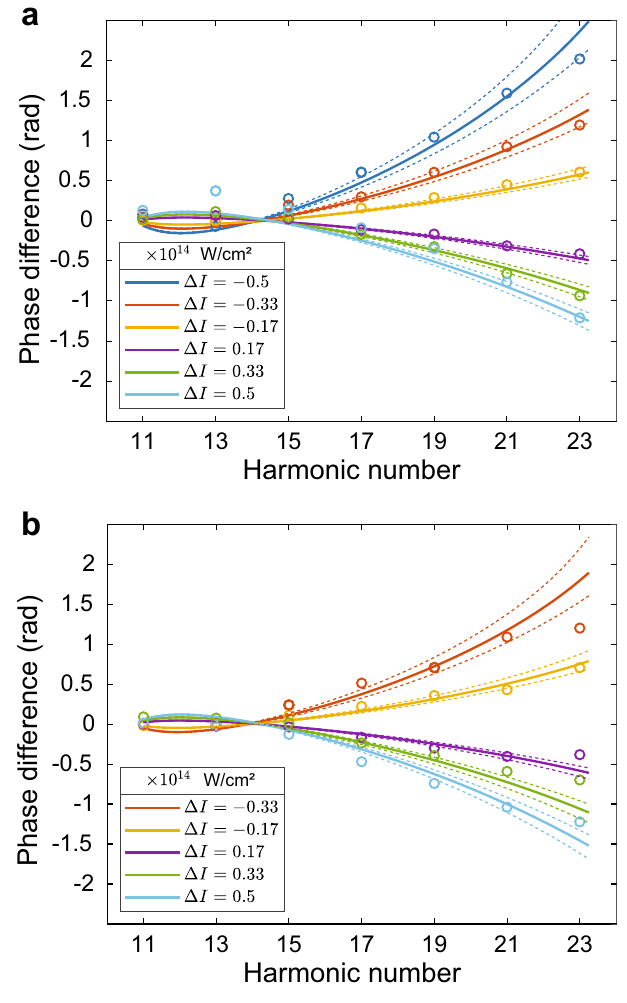
Figure 2. Differential phase measurements of the XUV phase. (a,b) Measured (circles) and calculated (lines) �φ(� , � I ) for argon (a) and nitrogen (b) at harmonics 11–23. For both targets, the reference intensity I 0 is 1.46 × 10 14 W cm − 2 . The dashed lines represent the uncertainty in the IR